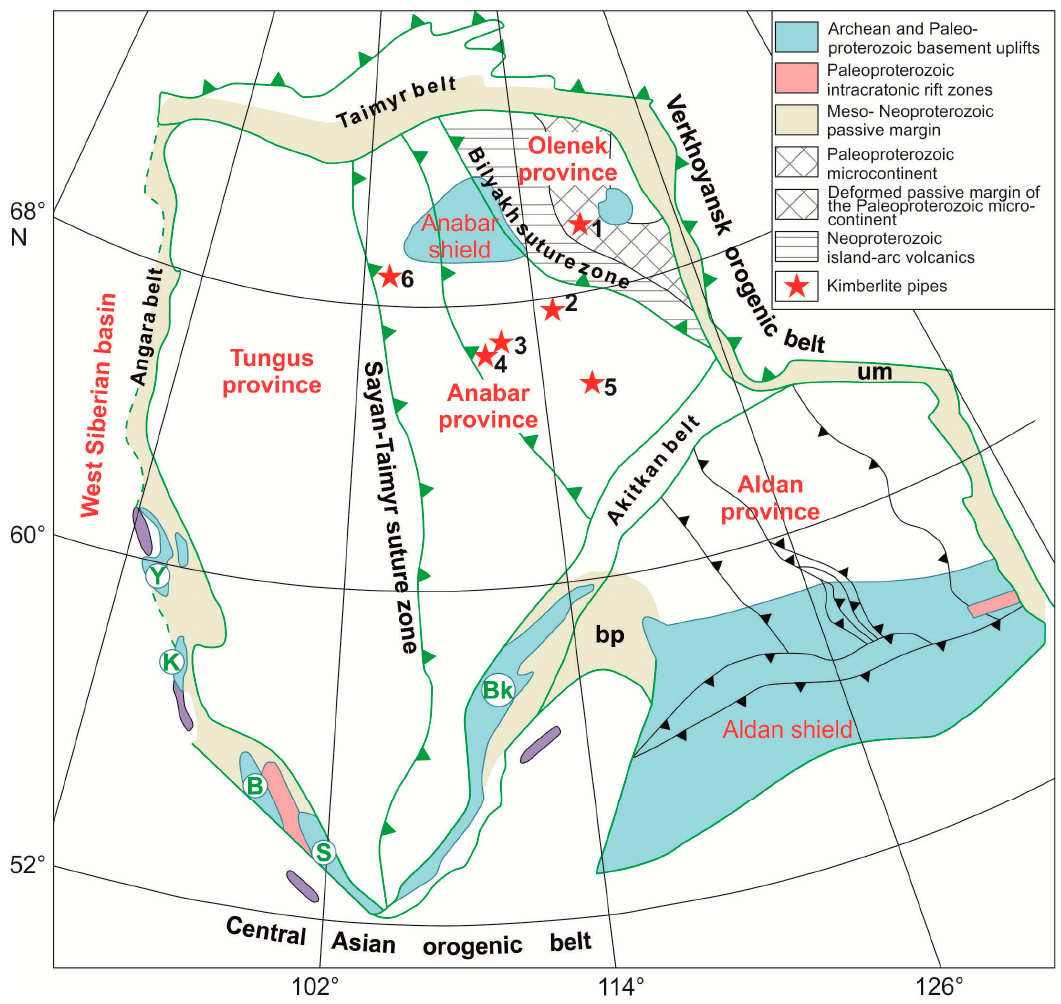
Figure 1. Geological scheme of the Siberian craton (modified after [1–3]. Green lines delineate the boundaries of the Siberian craton and its major units. Red stars represent kimberlite fields: